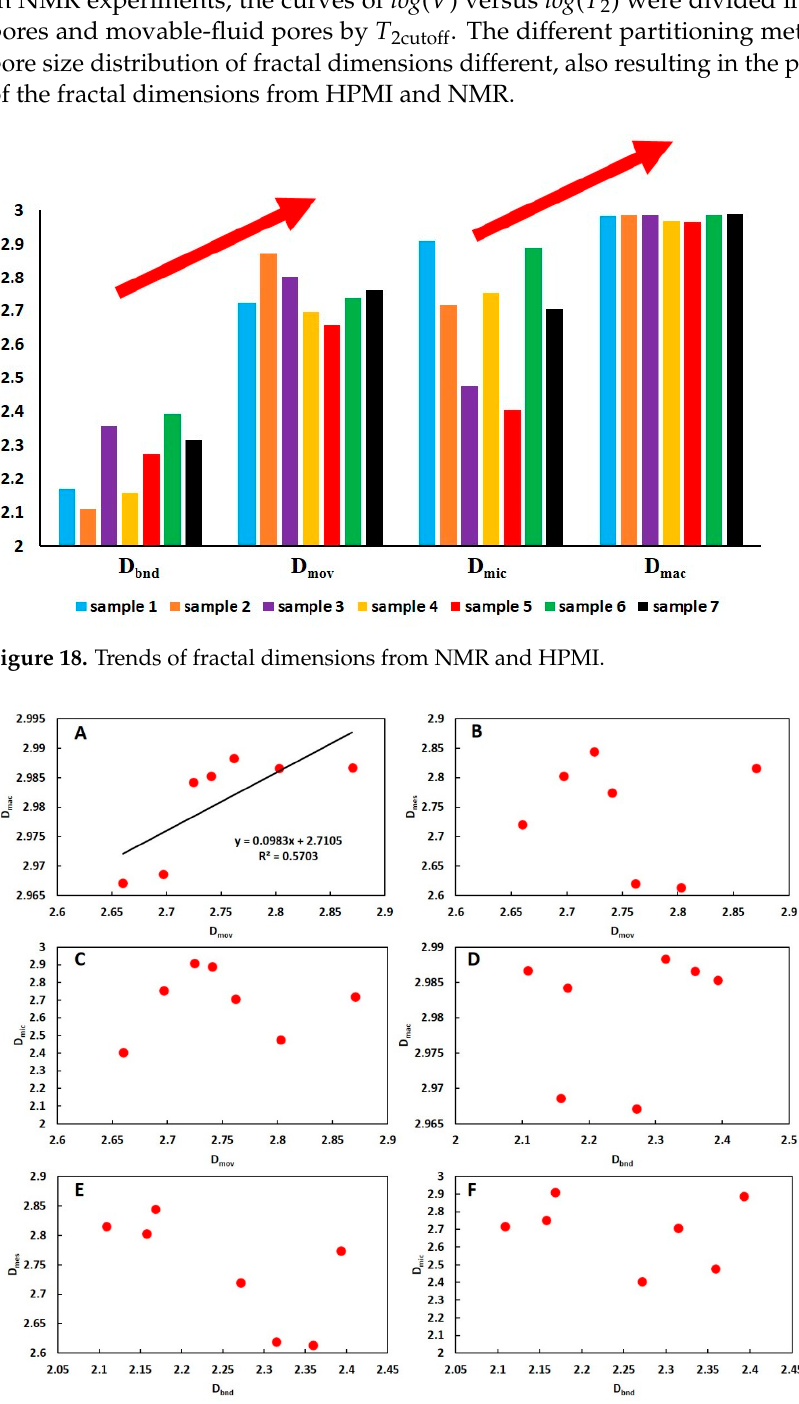
Figure 19. Plot showing the relationships between ( A ) D mov and D mac ; ( B ) D mov and D mes ; ( C ) D mov and D mic ; ( D ) D bnd and D mac ; ( E ) D bnd and D mes ; ( F ) D bnd and D mic .